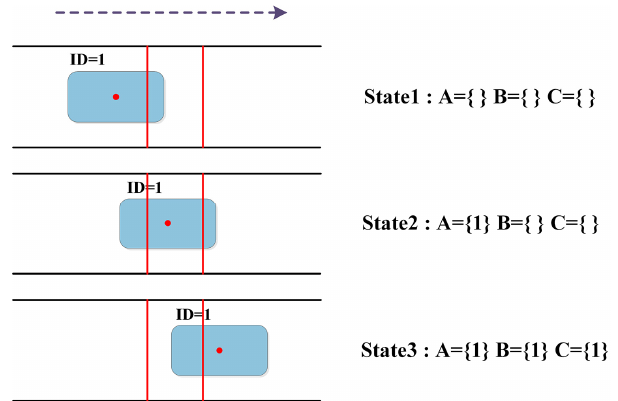
Figure 10. The schematic diagram of two-line detection method.